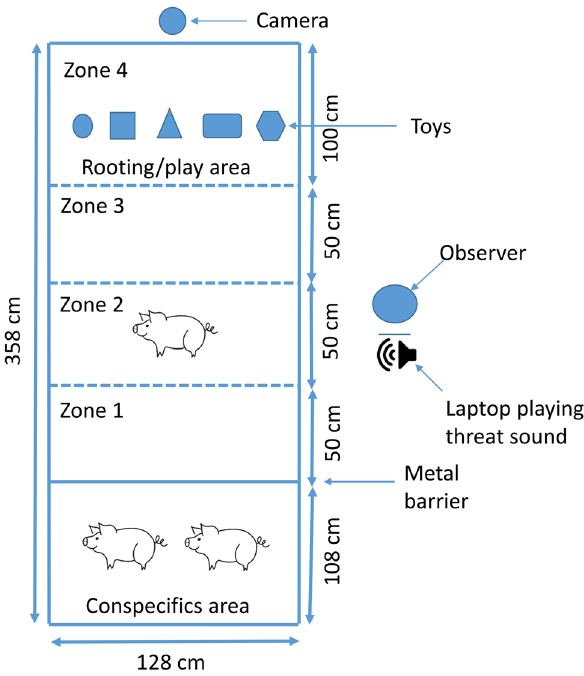
Figure 4. Attention bias arena. Pig vector from https:// pixab ay. com/ vecto rs/ pig- piglet- no- backg round- animal- 26603